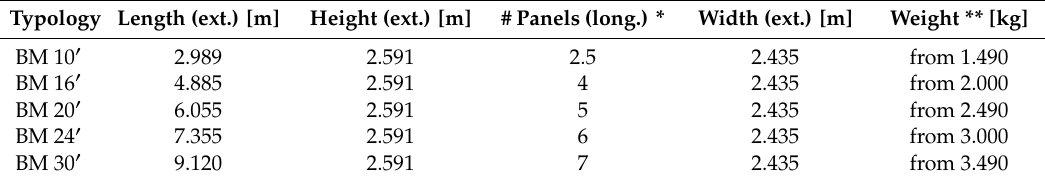
Table 1. Selected container typologies.